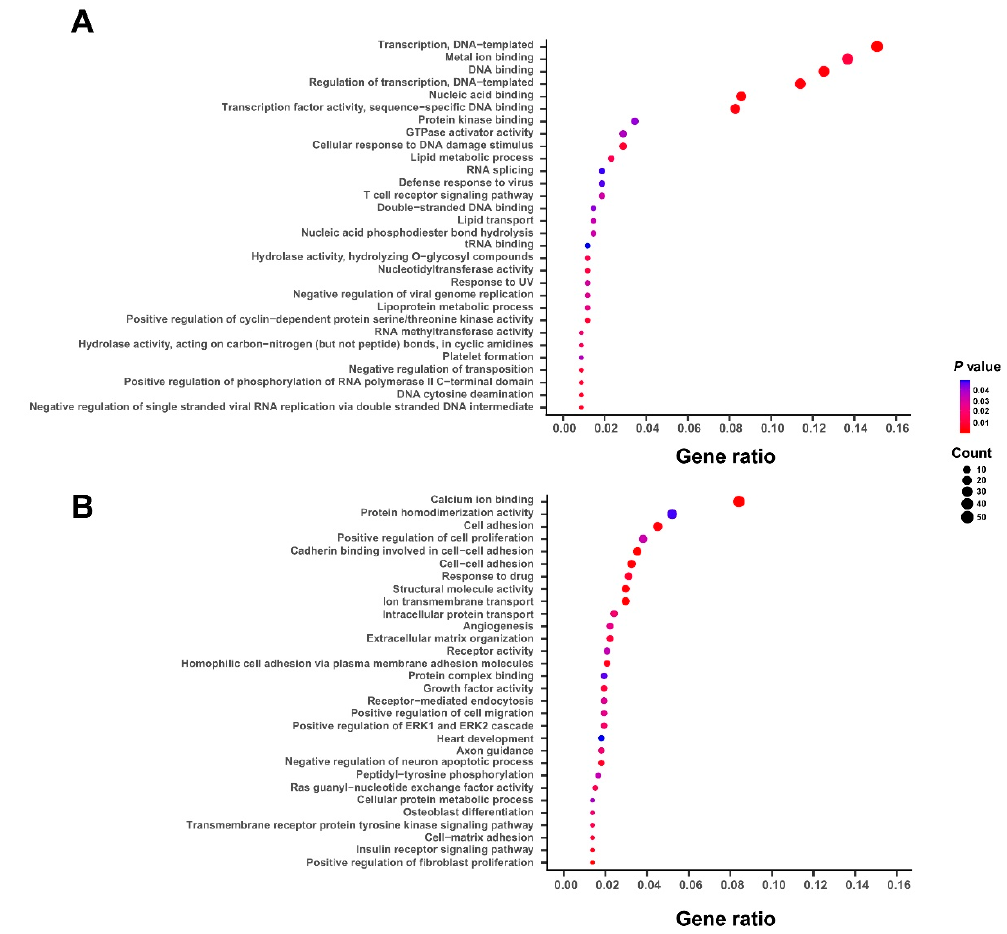
Figure 2. The functional enrichment analyses of 1078 survival-related genes. The gene ontology (GO) enrichment analyses of protective ( A ) and hazardous ( B ) genes in the selected set of 1078 survival-related genes that are important for the survival of BLCA patients. The GO terms were ranked according to the ratios of the involved genes and the top 30 significant GO terms with p -values < 0.05 are shown here.